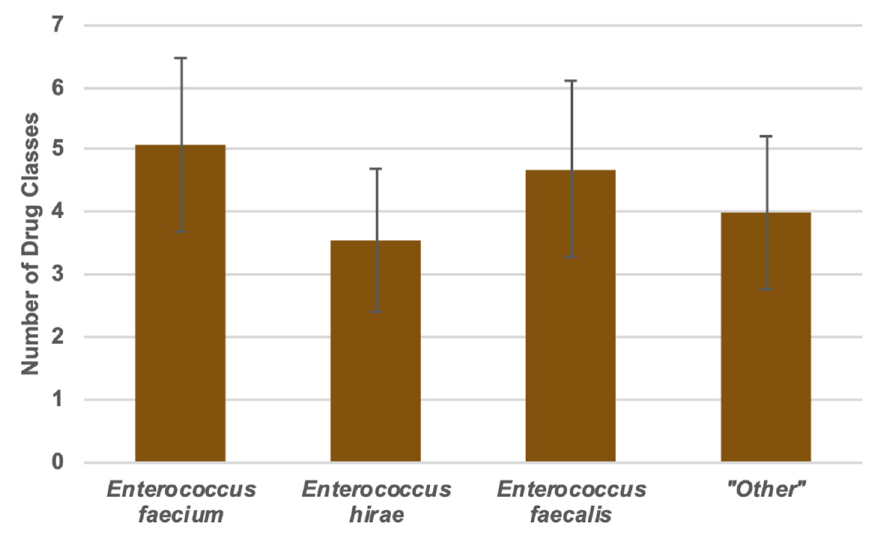
Figure 3. Multiple drug resistance in the form of total number of antimicrobials to which each species showed resistance (comparisons between E. hirae and “Other” were non-significant, p = 0.209).